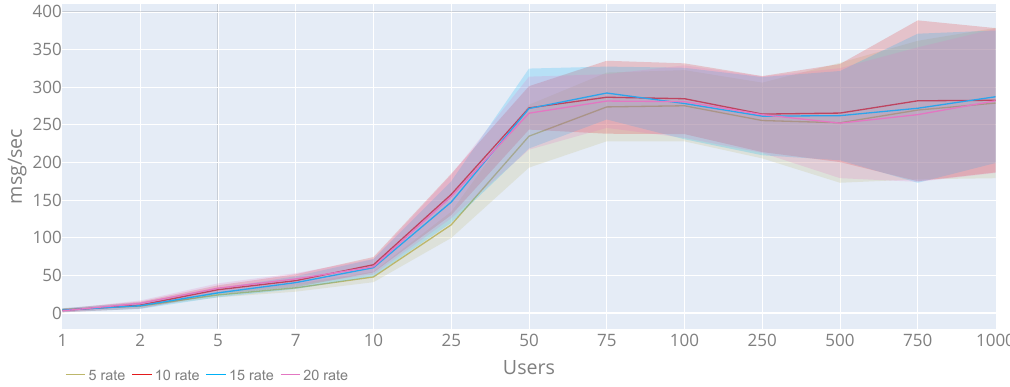
Figure 16. Average and standard deviation throughput of the API queries with a rate of 5, 10, 15 and 20 requests per second.